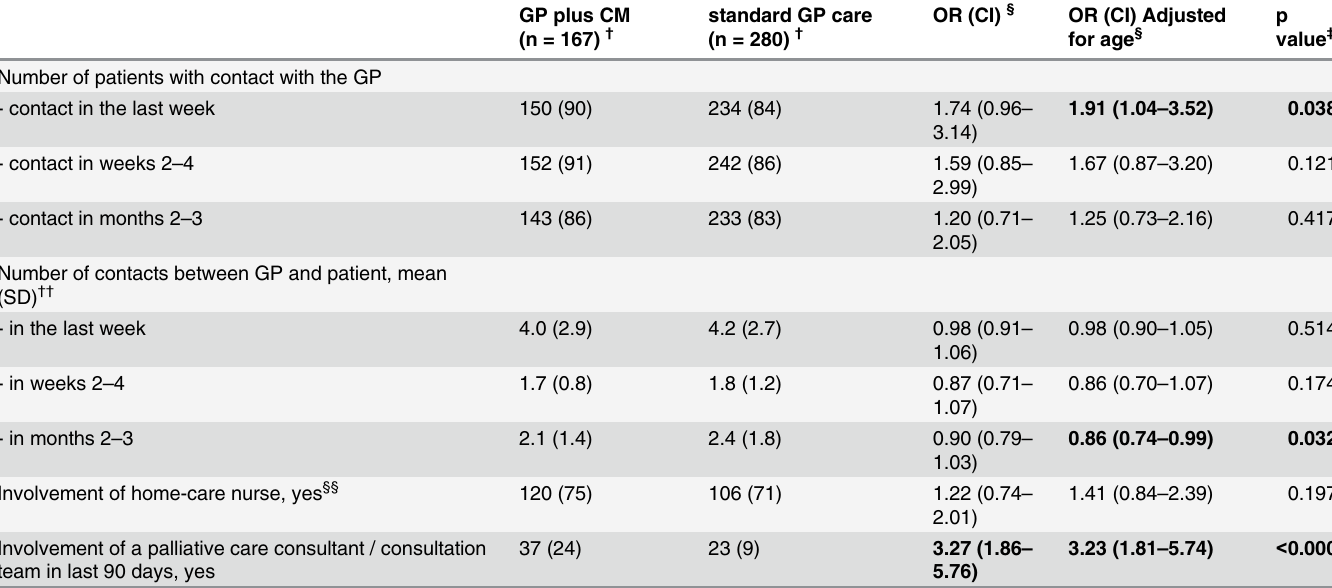
Table 2. Characteristics of care and support for cancer patients with additional support from a case manager and patients receiving standard GP care.